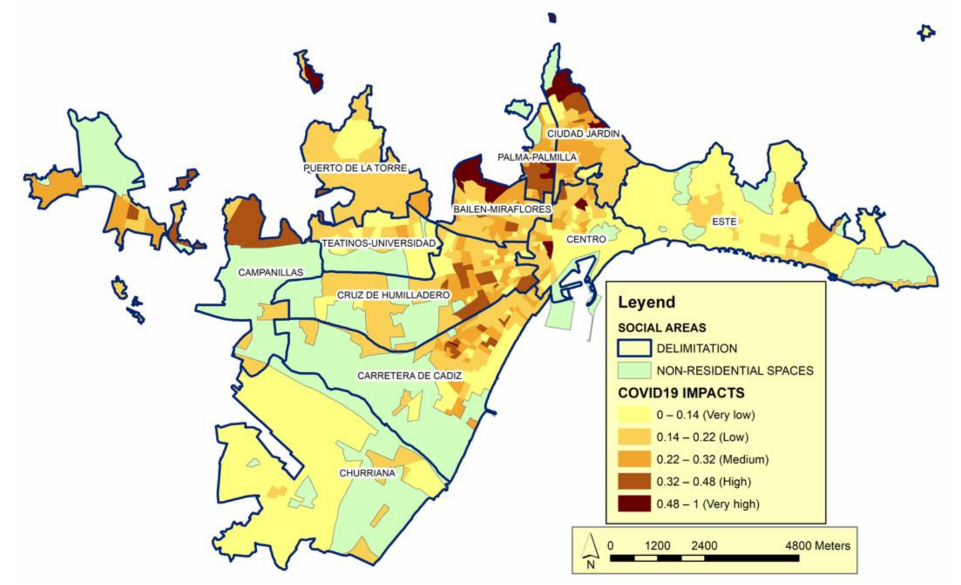
Figure 9. Global Impact Index. Source: Author’s elaboration. The Global Impact Index shows the correlation between the impact indices of the four categories: family status, social status, social care and spatial